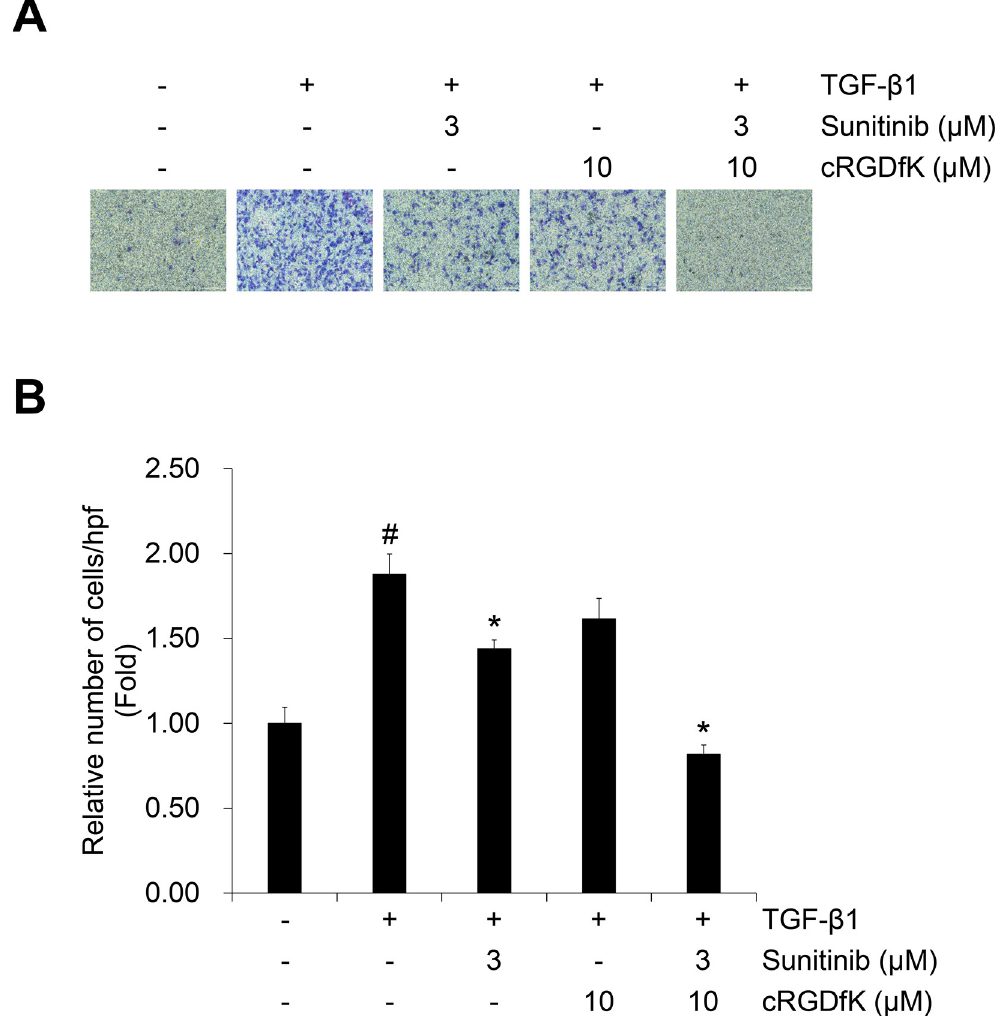
Fig 8. Combination of sunitinib with cRGDfK exerts enhanced inhibitory effect on TGF- β 1-induced invasion of A549 cells. The effect of combination on TGF- β 1-induced invasion of A549 cells was evaluated using Boyden chambers. Numbers of invaded cells were represented by an average number of cells per randomly selected three high-power field (HPF). Experiments were performed in triplicate. Data represent the mean ± SD of raw results. # p < 0.01 versus control, � p < 0.05, �� p < 0.01 versus treatment with TGF- β 1